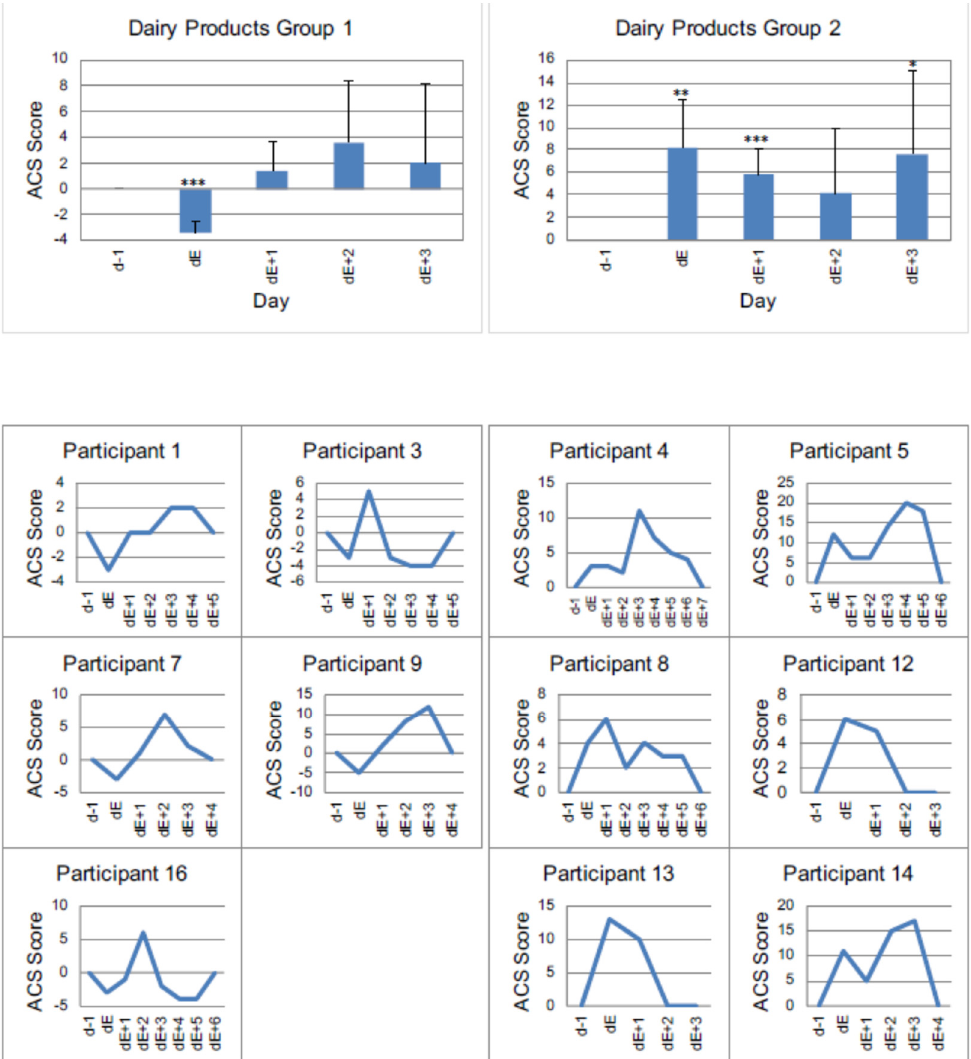
Figure 4. Individual reactions of participants to dairy products, measured by ACS. Group 1 (participants with a decrease of value in ACS at day of reintroduction) vs. Group 2 (participants with an increase of value in ACS at the day of reintroduction) p < 0.05 *, p < 0.01 **, p < 0.001 *** (one sided t -test). dE − 1: day before reintroduction, dE: day of reintroduction, dE + 1: day 1 after reintroduction etc. Table 3. Means and standard deviations of behavioral reactions to dairy products of Group 1 ( n =